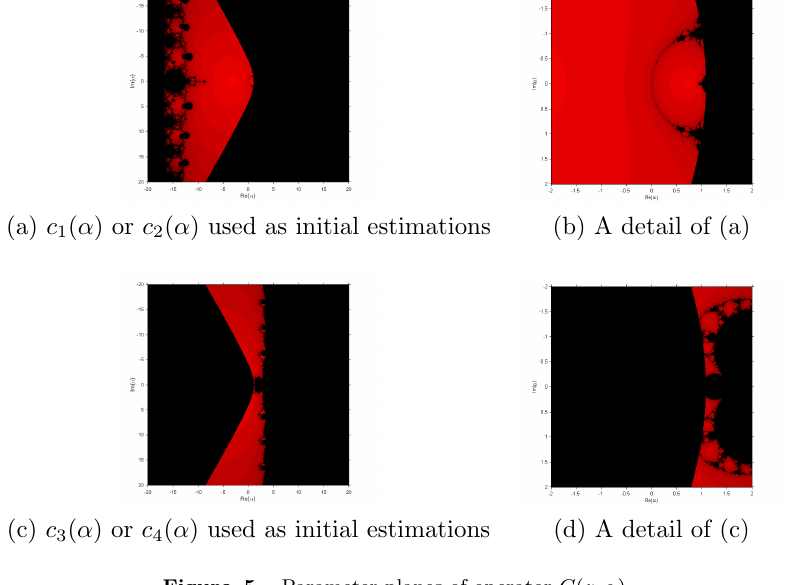
Figure 5. Parameter planes of operator G ( z,α